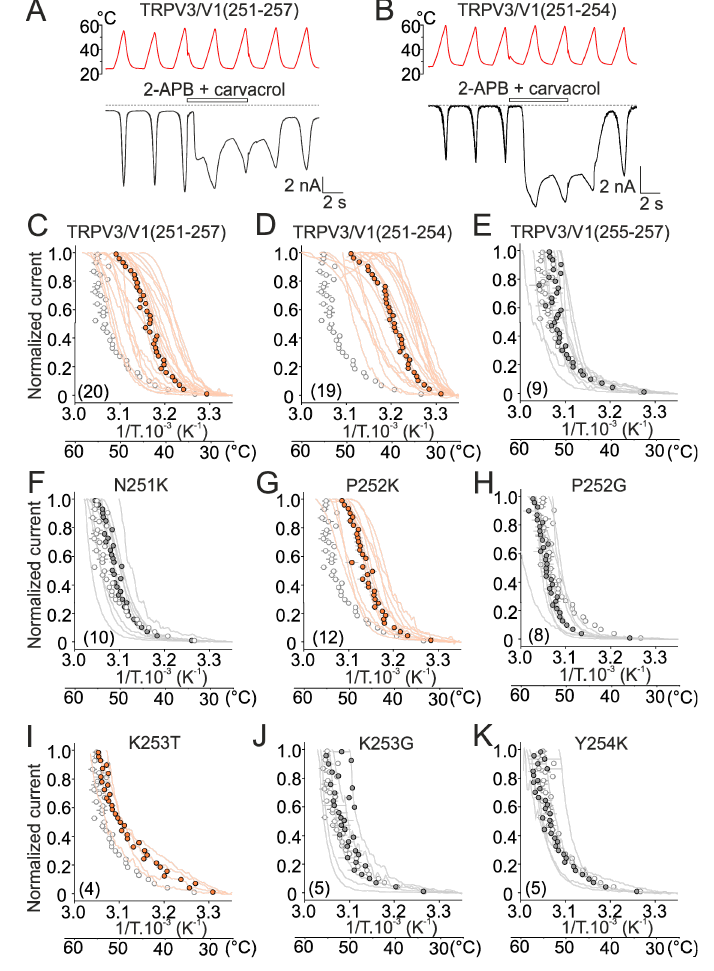
Figure 3. Mutations in the ARD finger 3 producing sensitized phenotypes. ( A , B ) Representative whole-cell recordings of currents evoked by repetitive heat stimuli from indicated chimeric TRPV3 / V1 channels recorded in the absence or presence of mixed agonists (100 µ M 2-APB + 100 µ M carvacrol). Holding potential, − 70 mV. ( C – K ) Heat responses from HEK293T cells expressing the indicated mutants of the finger 3, normalized to the maximum amplitude with average values overlaid (filled circles with gray error bars indicating S.E.M.). The average current for wild-type TRPV3 is overlaid for comparison as empty circles with grey bars indicating mean ± S.E.M. The number of cells is indicated in parentheses.